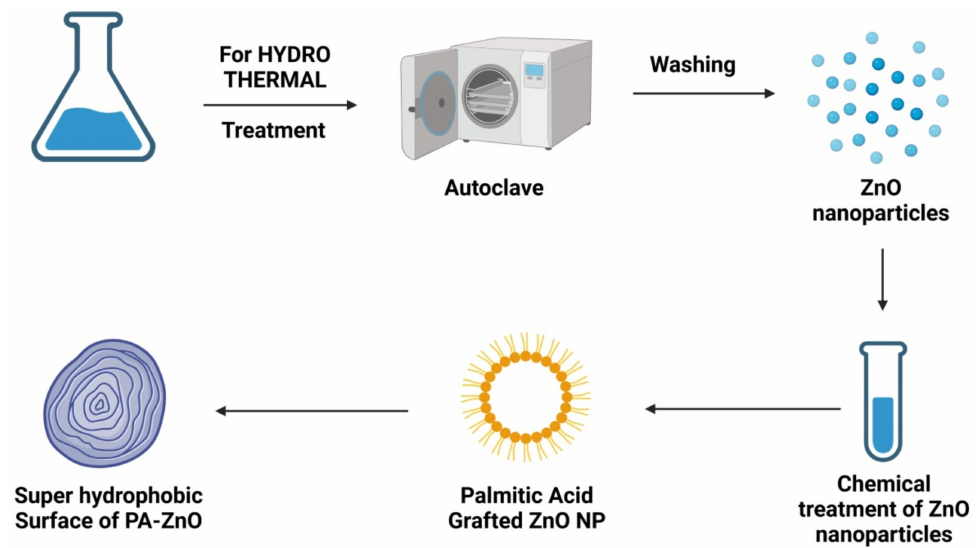
Figure 4. Diagrammatic representation of the stages required for metallic ZnO-NPs synthesis em- ploying the hydrothermal technique.